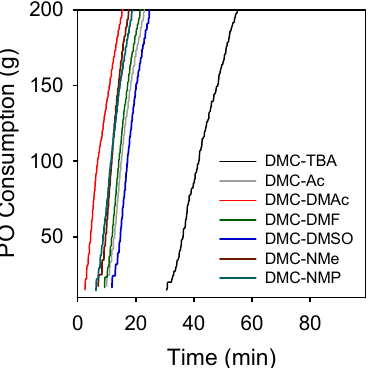
Figure 5. PO polymerization rate curves obtained by DMC-DMAc prepared at 70 °C using various amount of CA (left) and prepared at different temperatures using 1 mL of CA. Polymerization con-